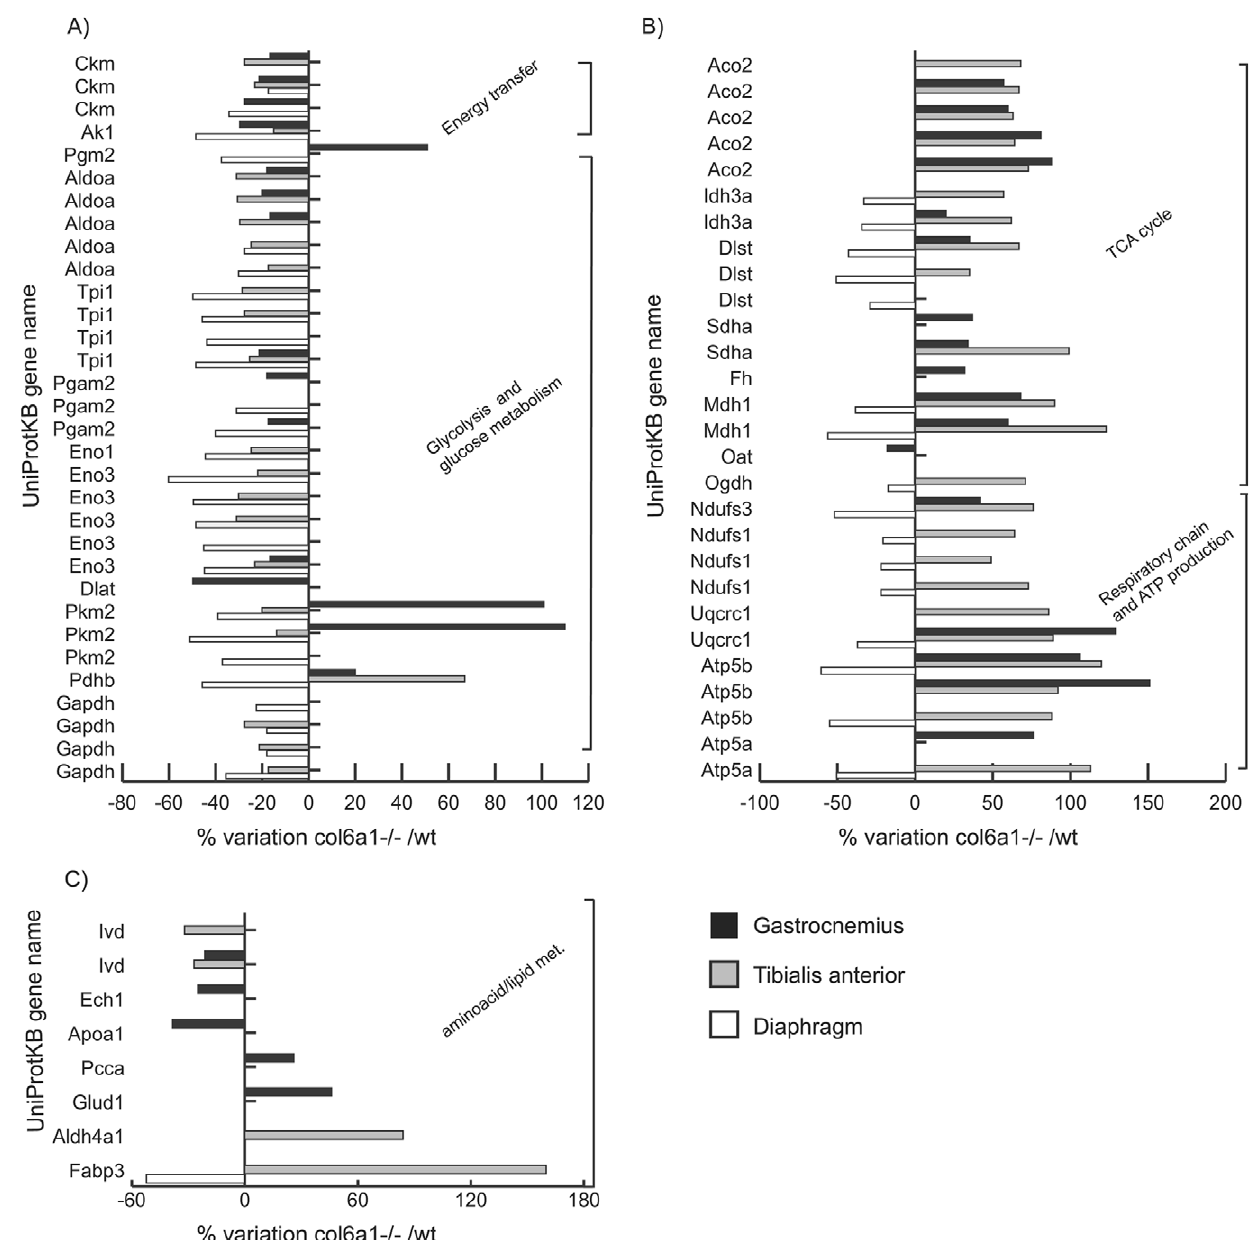
Figure 1. Histograms of differentially expressed metabolic proteins in muscles of Col6a1 2 / 2 versus wild-type controls. Histograms of differentially expressed proteins in gastrocnemius (black bars), tibialis anterior (grey bars) and diaphragm (white bars) muscles. Isoforms of proteins significantly altered (Student’s T-test, p , 0.01) are expressed as % of spot areas variation in Col6a1 2 / 2 versus wild-type controls. Panel A: energy transfer and glycolysis and glucose metabolism; panel B: TCA cycle, respiratory chain and ATP production; panel C: aminoacid and lipid metabolism. (Ckm: muscle creatine kinase; Ak1: adenylate kinase isoenzyme 1; Pgm2: phosphoglucomutase 2; Aldoa: fructose-bisphosphate aldolase A; Tpi1: triosephosphate isomerase 1; Pgam2: phosphoglycerate mutase 2; Eno1: enolase 1 (alpha); Eno3: enolase 3 (beta muscle); Dlat: dihydrolipoyllysine- residue acetyltransferase; Pkm2: pyruvate kinase isozymes M1/M2; Pdhb: pyruvate dehydrogenase (lipoamide) beta; Gapdh: glyceraldehyde-3- phosphate dehydrogenase; Aco2: aconitase 2; Idh3a: isocitrate dehydrogenase [NAD] subunit alpha; Dlst: dihydrolipoamide S-succinyltransferase; Sdha: succinate dehydrogenase complex, subunit A; Fh: fumarate hydratase 1; Mdh1: cytosolic malate dehydrogenase; Oat: ornithine aminotransferase; Ogdh: 2-oxoglutarate ( a -ketoglutarate) dehydrogenase; Ndufs3: NADH dehydrogenase (ubiquinone) iron-sulfur protein 3; Ndufs1: NADH dehydrogenase (ubiquinone) Fe-S protein 1; Uqcrc1: ubiquinol-cytochrome-c reductase complex core protein I; Atp5b: ATP synthase, H + transporting mitochondrial F1 complex, beta subunit; Atp5a: ATP synthase subunit alpha; Ivd: isovaleryl-CoA dehydrogenase; Ech1: delta (3,5)- delta(2,4)-dienoyl-CoA isomerase; Apoa1: Apolipoprotein A-I; Pcca: propionyl-CoA carboxylase alpha chain; Glud1: glutamate dehydrogenase 1; Aldh4a1: delta-1-pyrroline-5-carboxylate dehydrogenase; Fabp3: fatty acid-binding protein).